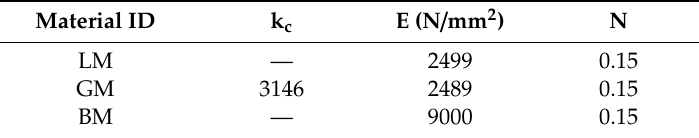
Table 5. Assumed elastic constants of the used